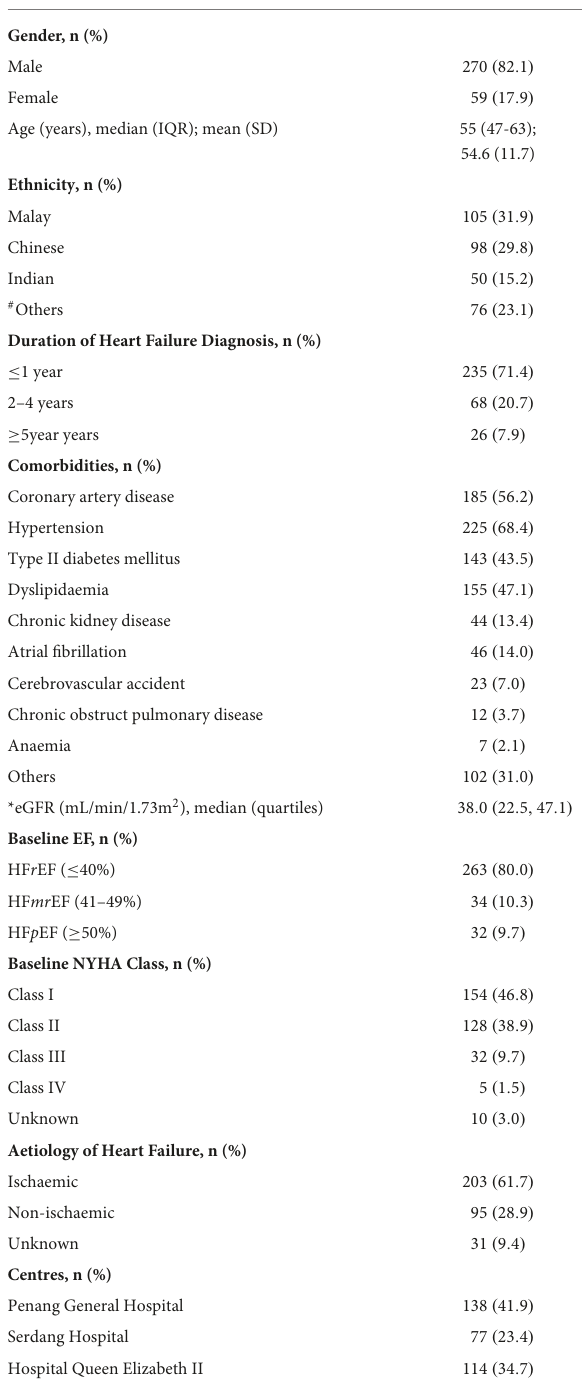
TABLE 1 Baseline demographic characteristics of heart failure